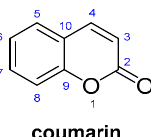
Figure 1. Structure of coumarin nucleus.